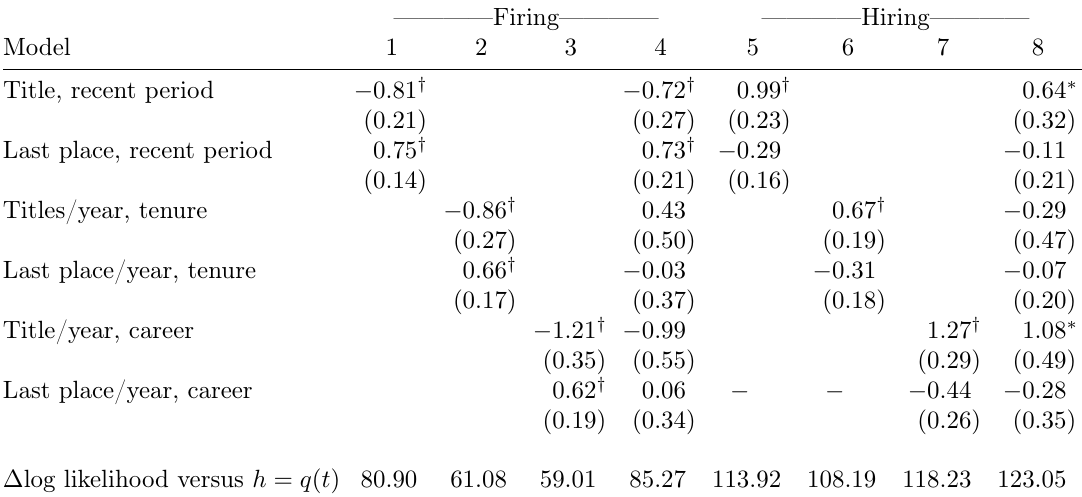
Table 3: Partial likelihood estimates of the hazard of firing and hiring field managers in Major League Baseball,